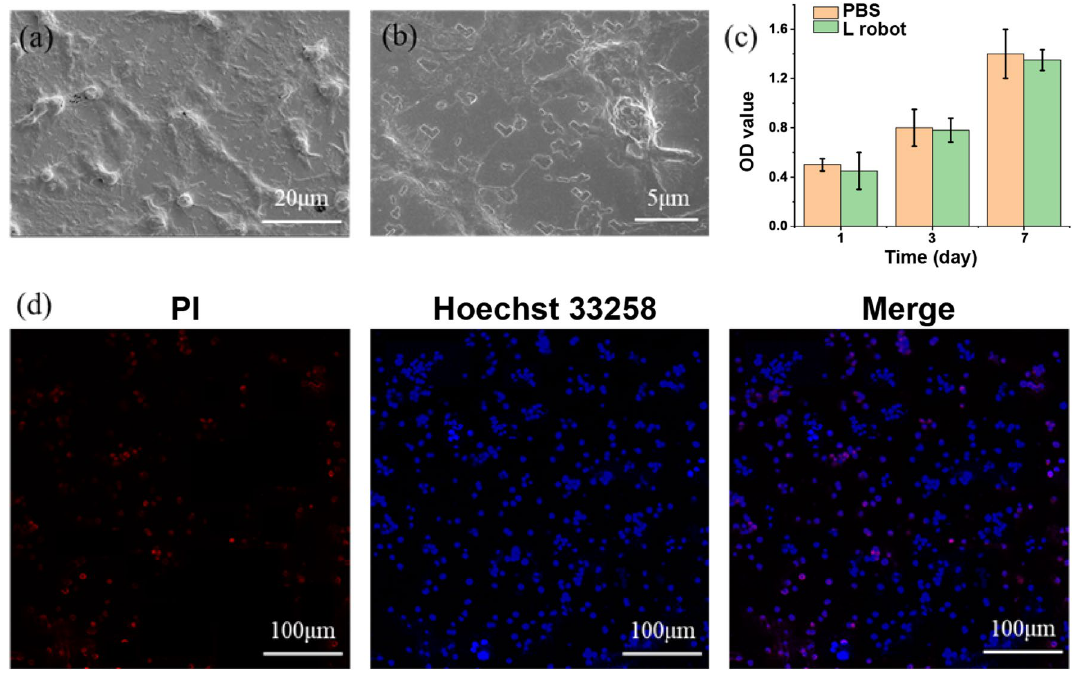
Figure 5. Cell cytotoxicity tests with HepG2 cancer cells. SEM image ( a ) and a zoom-in view ( b ) of L-shaped nanorobots cultured with HepG2 cancer cells. ( c ) Cell viability test using CCK-8 assay. ( d ) Live/dead by Hoechst 33258 (blue) /PI (red) staining.